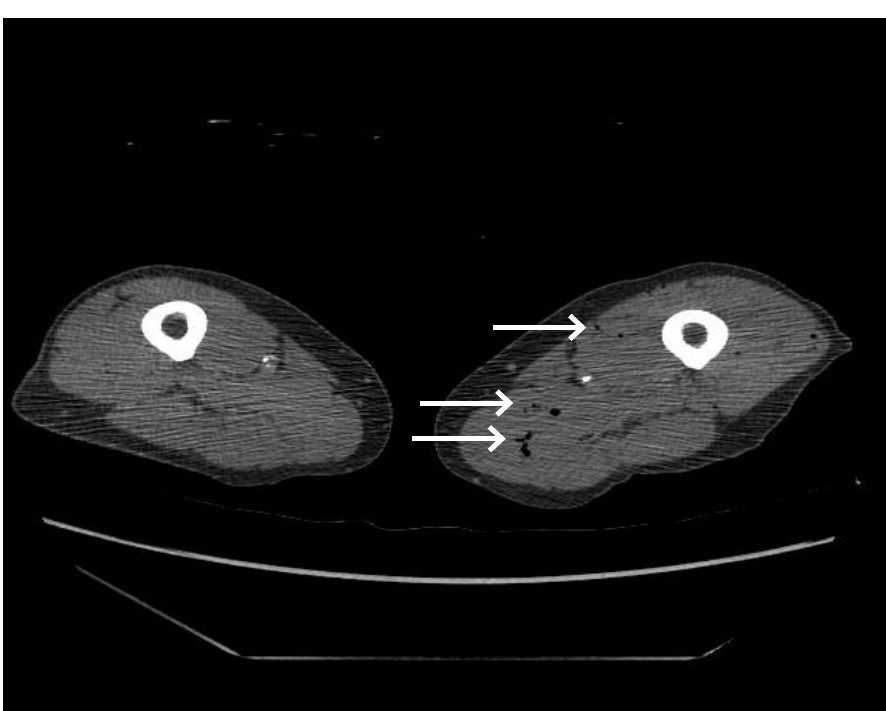
Image 3 . Computed tomography angiography of bilateral lower extremities displaying intramuscular gas, signifying myonecrosis in both thighs